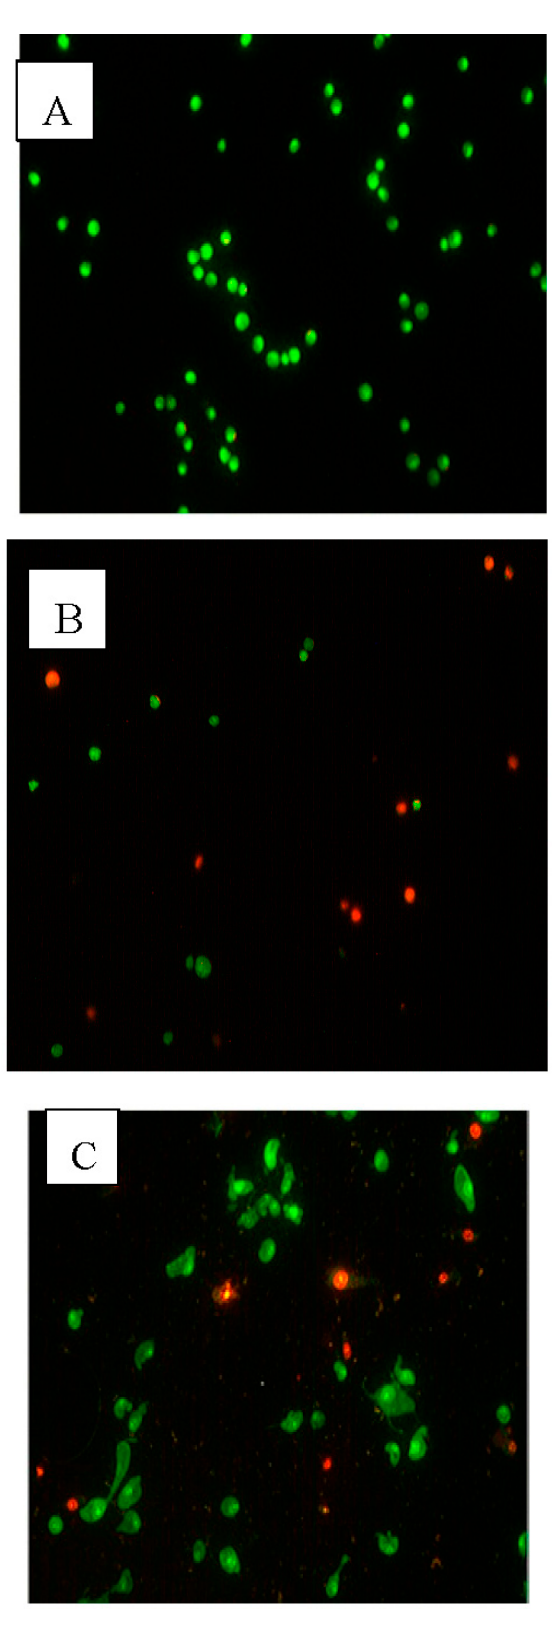
Figure 3. Fluorescent images of MCF-7 cells stained by AO/PI. ( A ) Control cells (×200); ( B ) treated with 0.1% DMSO for 48 h (×200); ( C ) treated with 25 µg/mL PVLH-EAE for 48 h (×200).